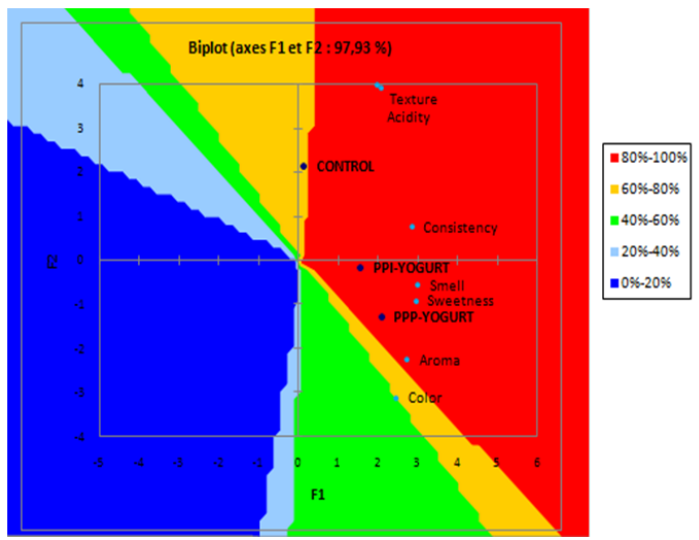
Figure 5. Preference mapping of the three assessed yogurts. PPP-YOGURT: yogurt fortified with potato peel powder, PPI-YOGURT: yogurt fortified with potato peel pieces. The non-enriched control yogurt is located in the yellow zone corresponding to the judges’ satisfaction percentages ranging from 60% to 80%. Enriched yogurts are in the red zone, which corresponds to the percentages of satisfied judges ranging from 80% to 100%. For characteristics, those that correlate are close, such as texture and acidity; smell and sweetness; aroma and color.